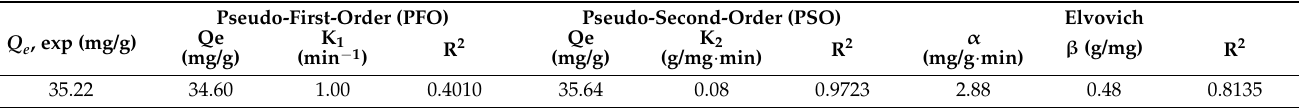
Figure 5. ( a ) Time effect and sorption kinetics (initial concentration = 20 mg/L, time = 1–30 min, and T = 298 K); and the initial concentration effect and sorption isotherms of CTAB@FZA towards Cr(VI) removal at ( b ) 298 K, ( c ) 318 K, and ( d ) 338 K (initial concentration = 10–300 mg/L, contact time = 10 min). Adsorbent dose = 0.5 g/L and pH = 3. Table 2. Adsorption kinetic parameters of CTAB@FZA towards Cr(VI).